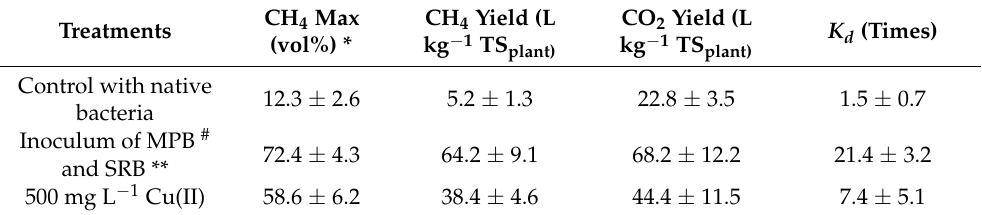
Table 2. The effectiveness of the fermentation process in the presence of Cu(II).